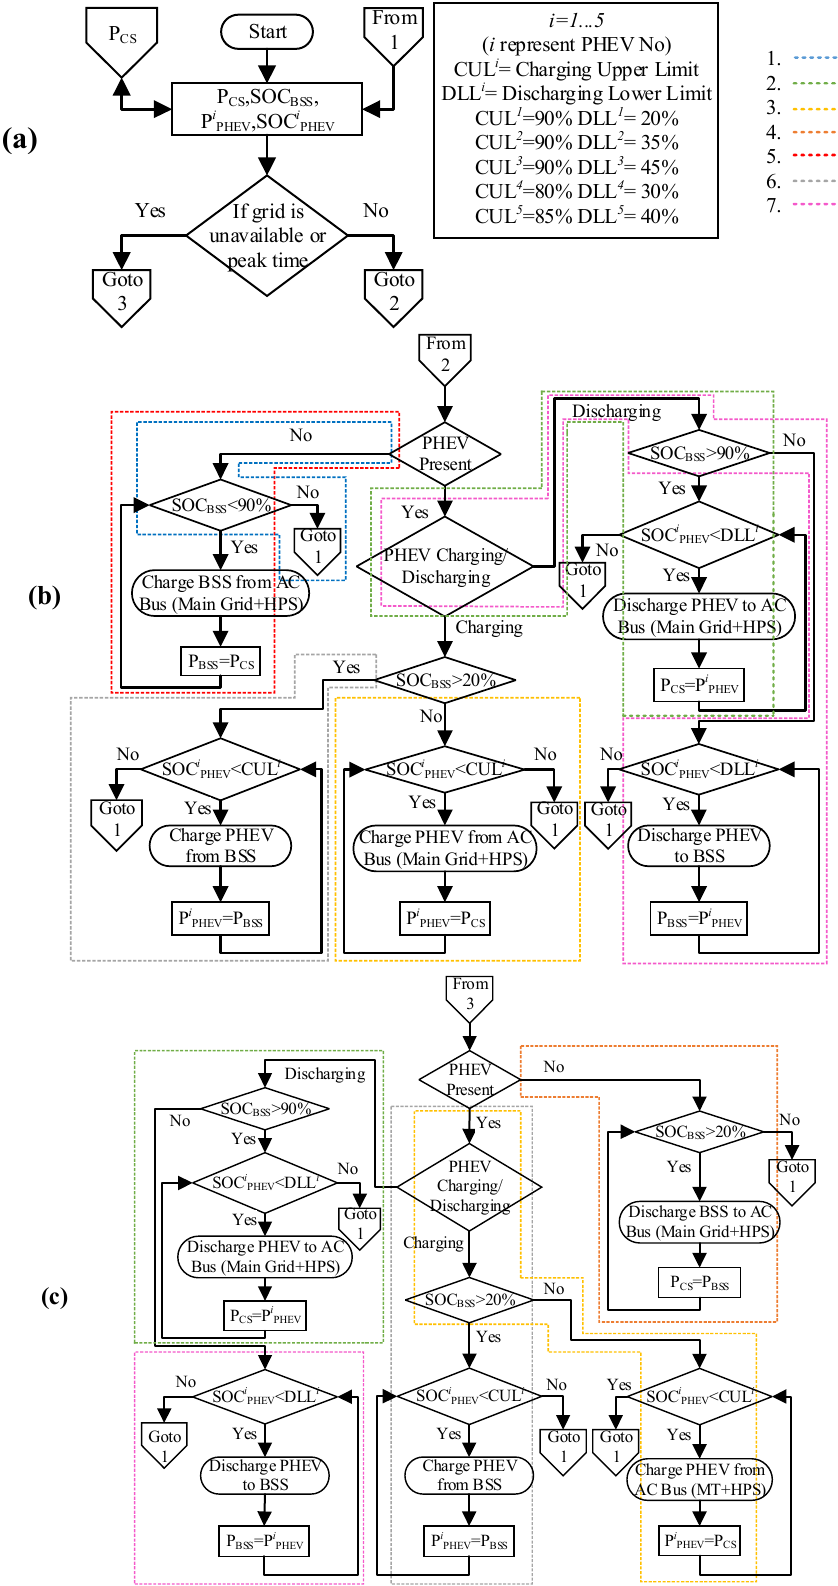
Figure 6. Flow chart of the proposed PMS: ( a ) initial decision stage of the PMS; ( b ) PMS working at off peak hours; and ( c ) PMS working at peak hours.